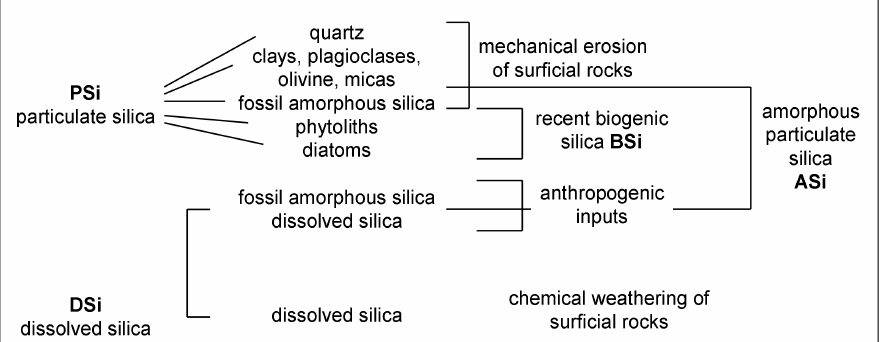
Fig. 1. Sources and forms of riverine